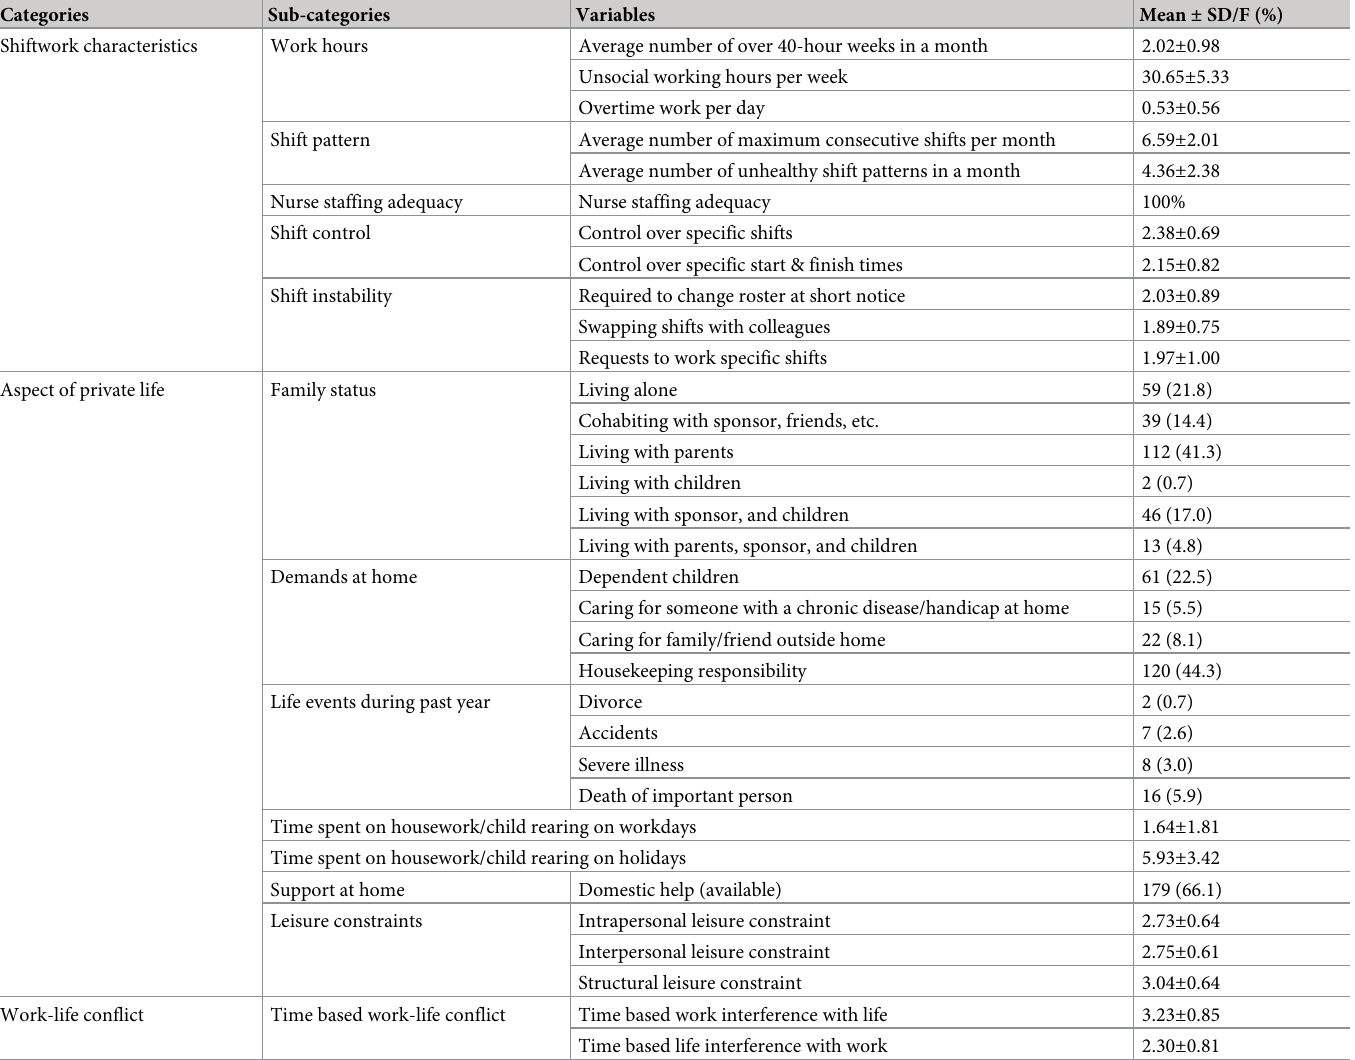
Table 3. Results of shiftwork characteristics, aspects of private life, and work-life